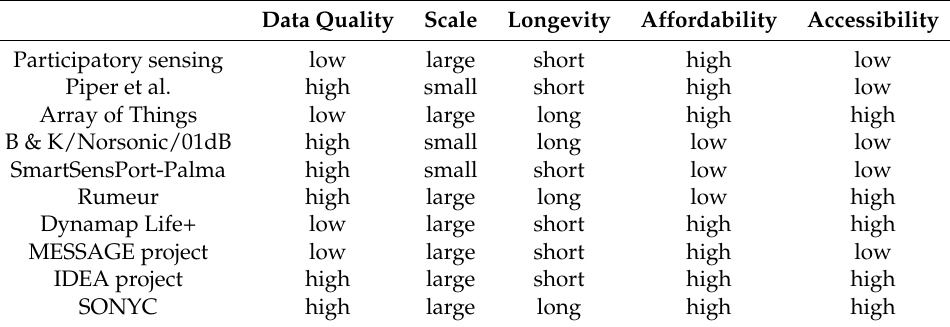
Table 1. Existing sensor network literature